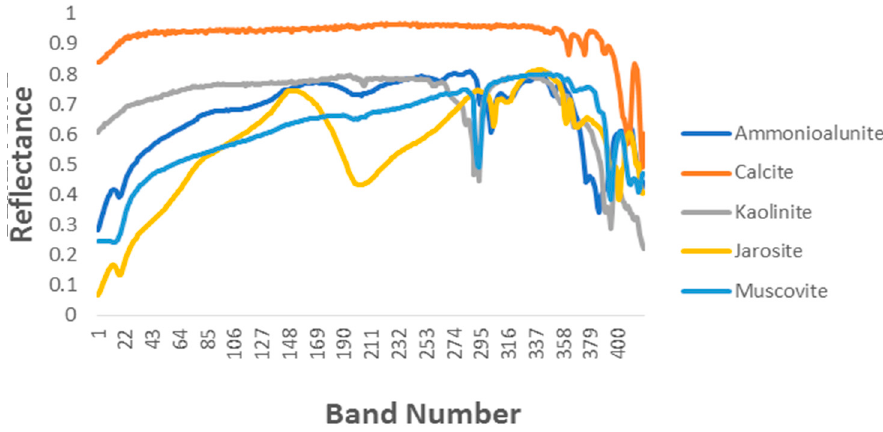
Figure 7. Five endmember signatures extracted from the USGS Spectral Library.